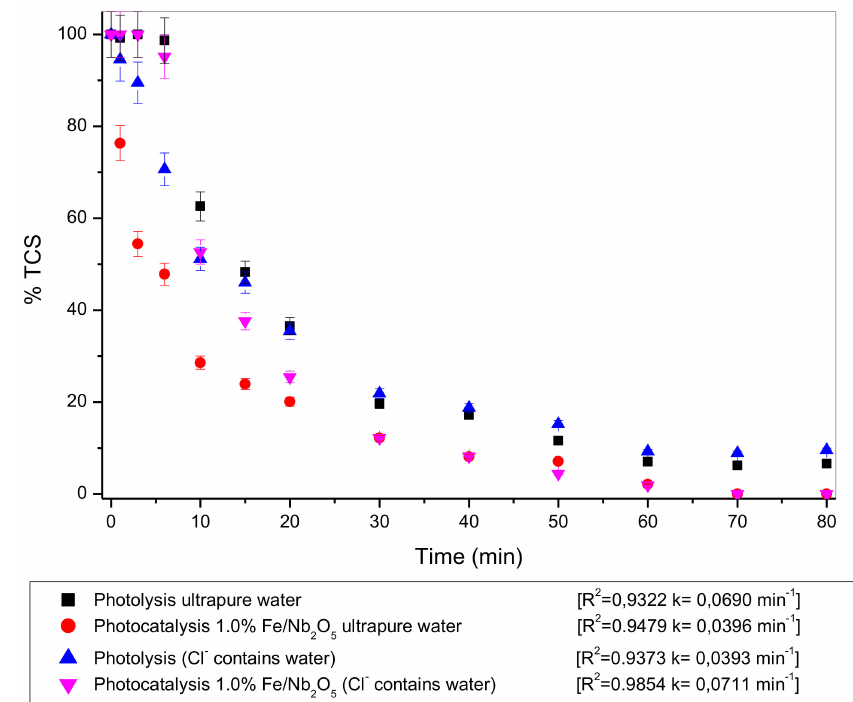
Figure 6. Photo catalysis and photolysis in different